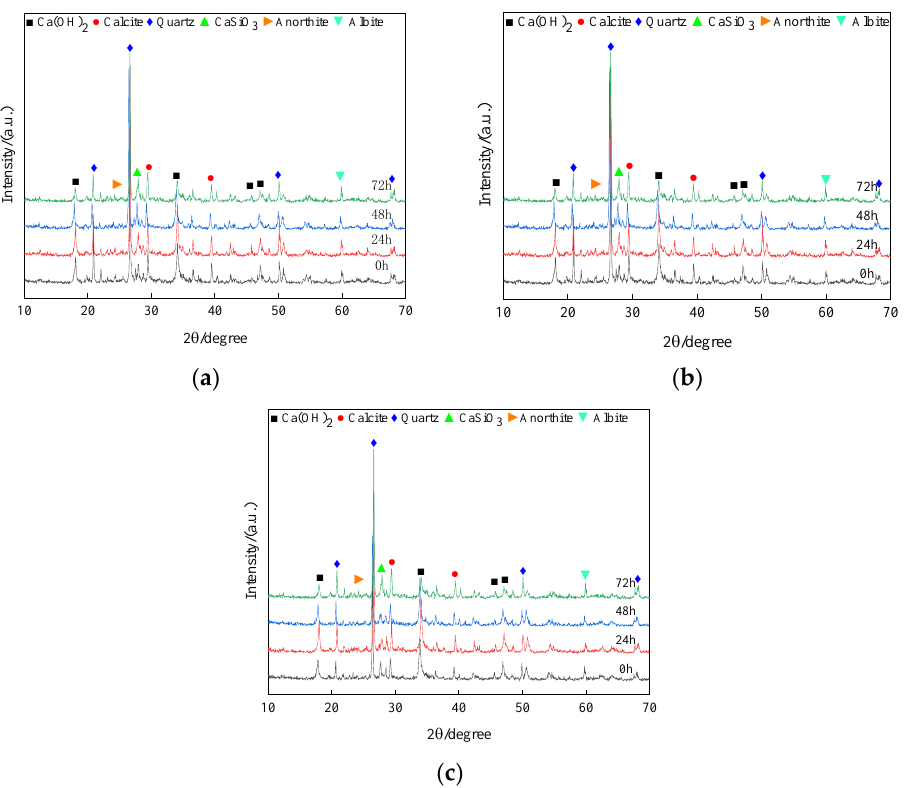
Figure 9. XRD of different amounts of lime slaked for 0 h, 24 h, 48 h and 72 h under standard curing: ( a ) M = 10%; ( b ) M = 15%; ( c ) M = 20%.